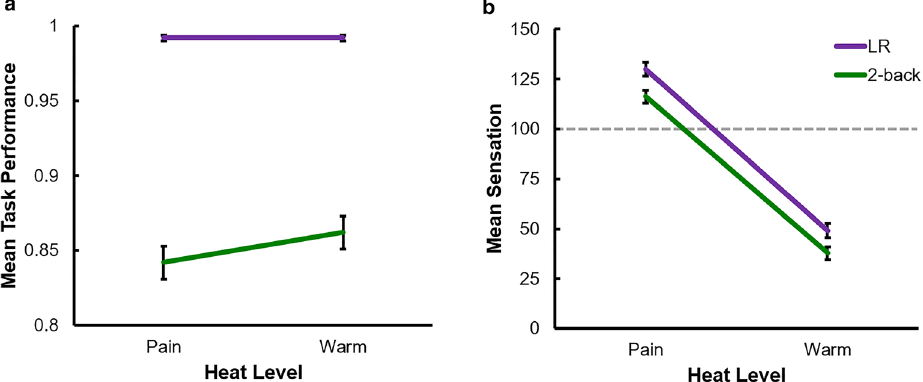
Figure 2. ( a ) Effects of task difficulty on mean performance and ( b ) effects of heat level on reported thermal sensation for the Left–Right and 2-back tasks. The grey line in ( b ) indicates pain threshold. Error bars represent standard error of the